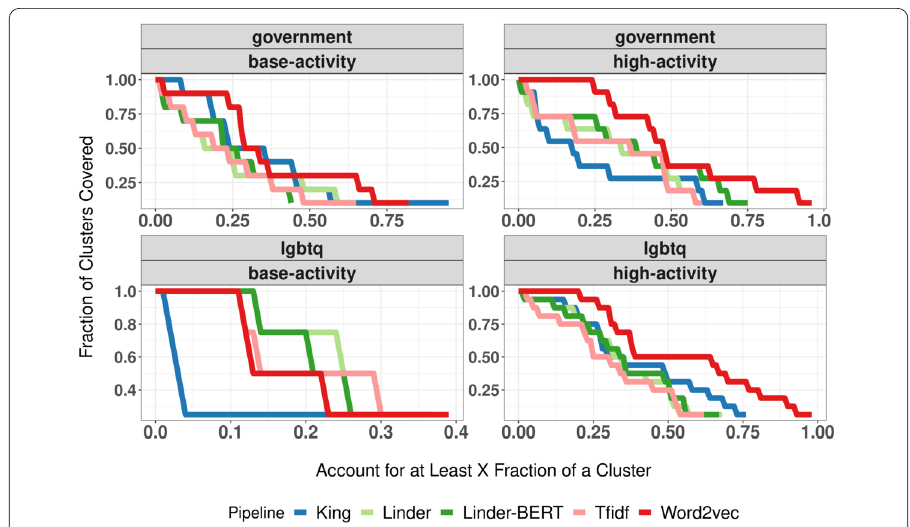
Figure 5 Topic Coverage. The y -axis denotes the fraction of topics that has at least X fraction of coverage by a pipeline (separated by color). As a example, we see that for the lgbtq movement in high-activity level, Word2vec is able to identify at least 25% of the tweets for 94% of all